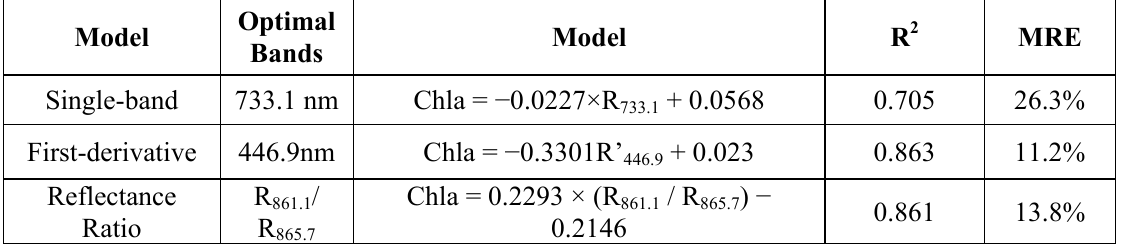
Table 2. Regression models for Chl- a with three types of spectrum indices. Optimal Model Bands